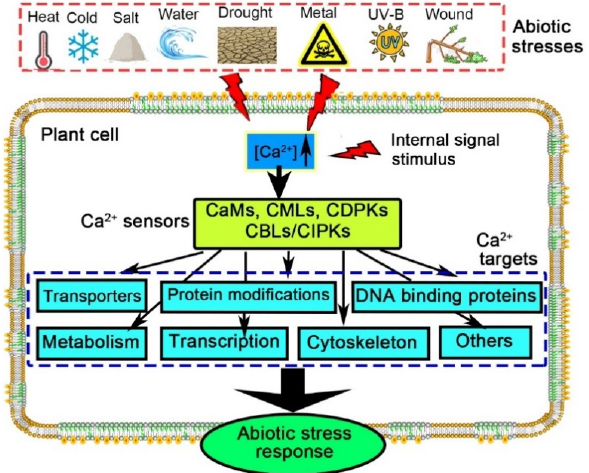
Figure 1. The Ca 2+ signaling network in plant cells. Abiotic stress, including high-temperature stress (heat), low-temperature stress (cold), salt stress (salt), waterlogging stress (water), drought stress